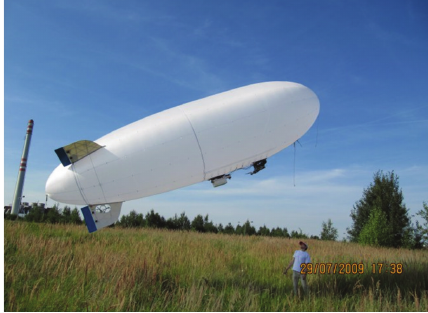
Figure 1: Remotely controlled airship used in measurements.